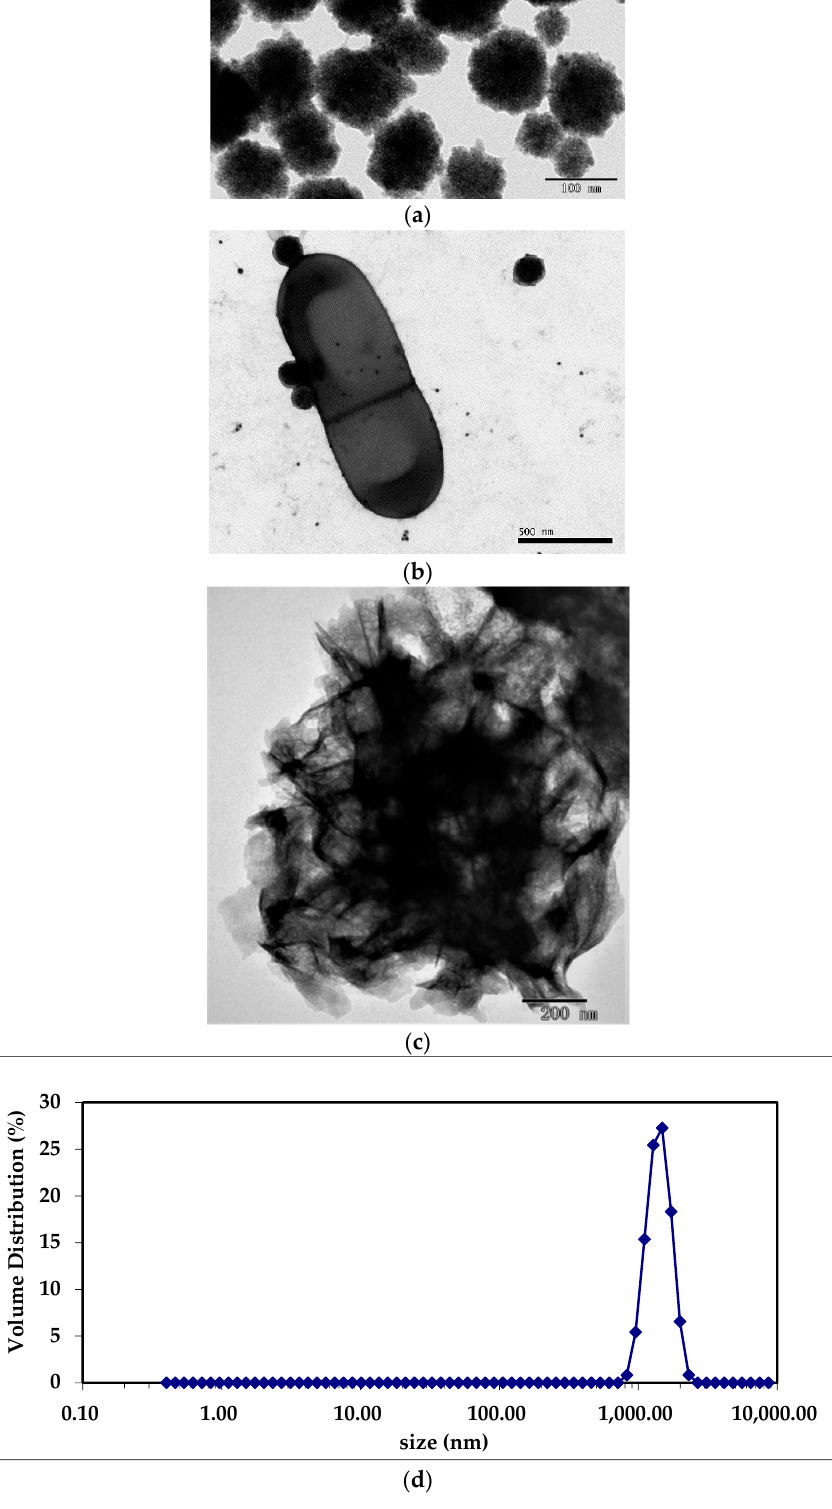
Figure 1. ( a ) TEM image of the immune magnetic nanobeads; ( b ) TEM image of the magnetic bacteria; ( c ) TEM image of the immune CaNFs; ( d ) Dynamic light scatting result of the immune CaNFs.